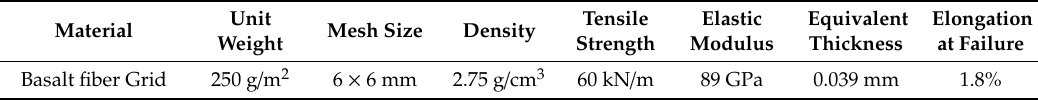
Figure 1. Basalt grid photo. Table 2. Mechanical properties of the basalt grid (manufacturer data).